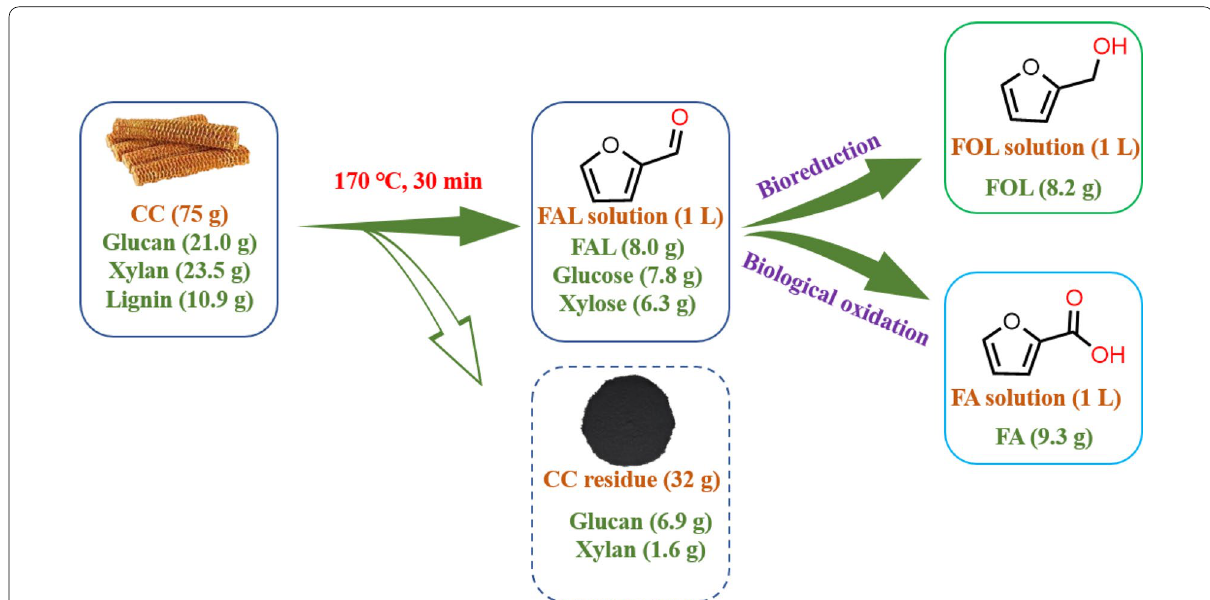
Fig. 7 Mass balance from biomass into furran